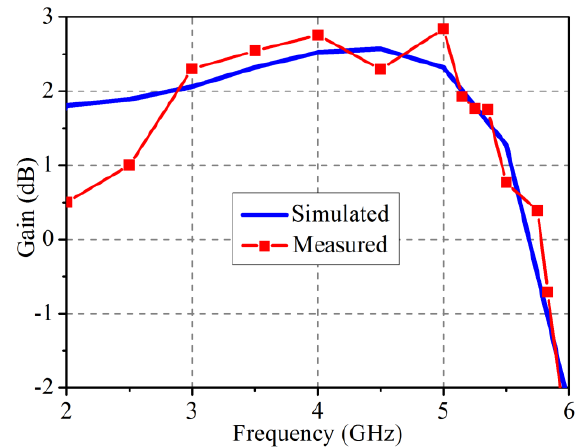
Figure 13: Measured and simulated gain of the proposed multiband